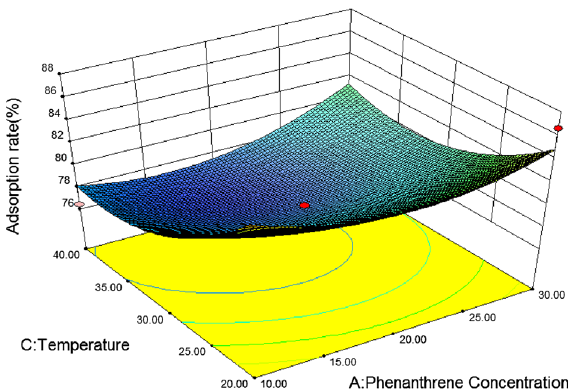
Figure 12. Effects of initial phenanthrene concentration and temperature on silty sand adsorption